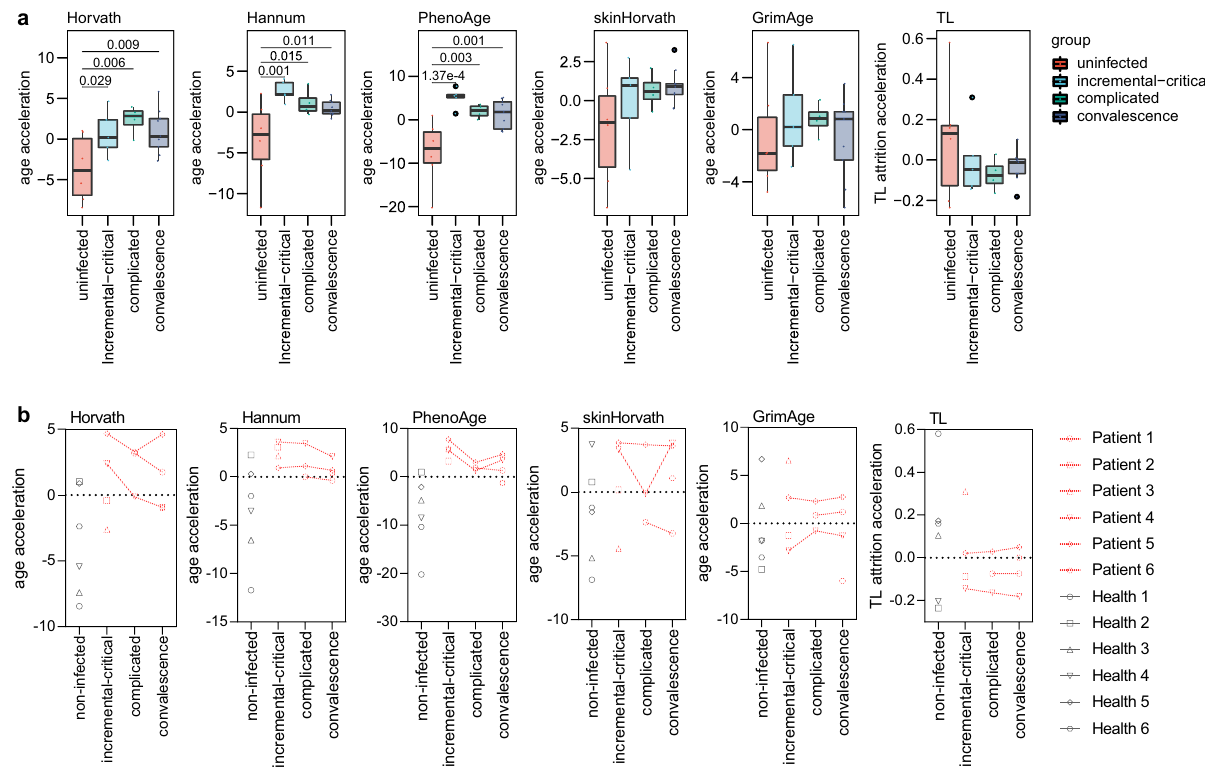
Fig. 3 Epigenetic aging across COVID-19 disease phases. a Acceleration of DNAm aging ( fi ve epigenetic clocks) and telomere attrition of the blood samples collected from uninfected control and patients at each clinical disease phase. b Dynamic change of epigenetic age acceleration in each individual across COVID-19 disease phases. The p value for each t-test is shown above the corresponding line. In the box plots, the lower and upper hinges indicate the 25th and 75th percentiles, and the black line within the box marks the median value. The whiskers extend from the hinges to the largest and smallest values no further than 1.5 × inter-quartile range from the hinges, and the points beyond the end of whiskers indicate outliers. Source data are provided as a Source Data fi telomere length estimator to determine the epigenetic age of the infection and developing severe COVID-19. In addition, we whole blood in COVID-19 patients and healthy individuals. We found a reversible in fl uence of COVID-19 syndrome on epige- observed strong correlation of the epigenetic clocks with the netic aging in some COVID-19 patients with the longitudinal chronological age and increasing acceleration of epigenetic aging DNA methylation pro fi ling analysis. Overall, these fi ndings in the blood samples of healthy individuals and COVID-19 suggest that COVID-19 may perturb the epigenetic clock and patients. Our epigenetic study with consistent fi ndings from telomere length. Although the epigenetic clocks and telomere different epigenetic clocks provides evidence for the association length are known as independent 28,29 , DNAm aging was paral- lelled by a telomere shortening in all the observations. of accelerated epigenetic aging with the risk of SARS-CoV-2